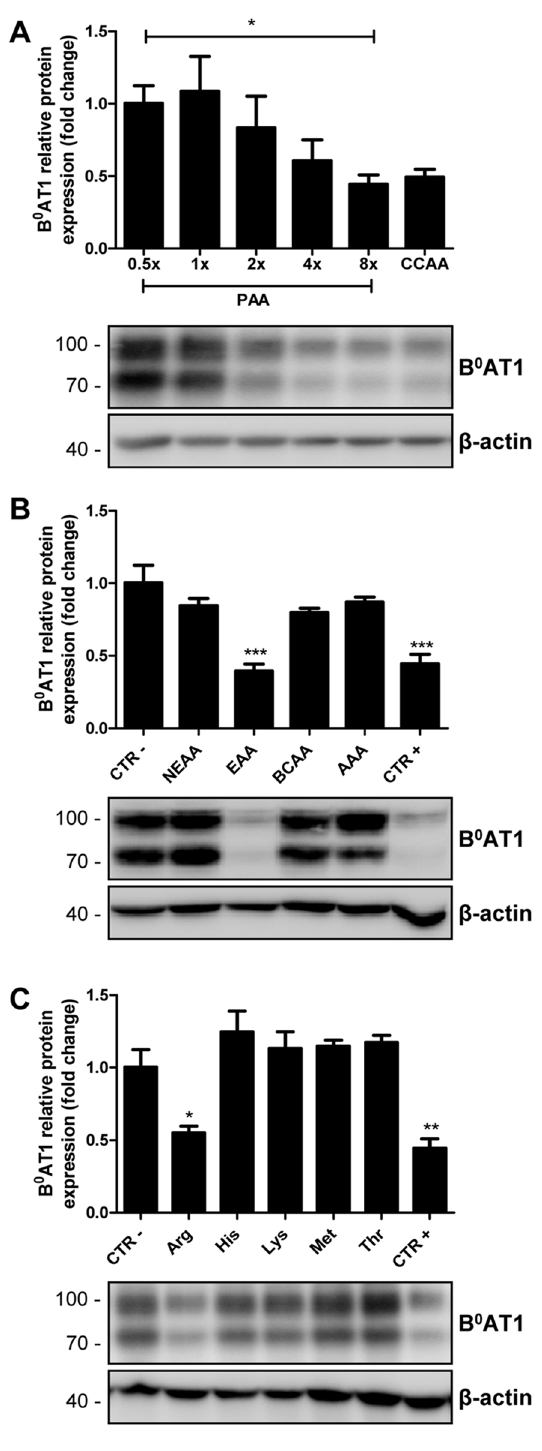
Figure 3. Transgene regulation by amino acids. A: Mycoplasma- infected B 0 AT1-TMEM27 overexpressing MDCK cells were incubated in standard cell culture medium (CCAA) or in amino acid-free medium complemented with different amounts (0.5 6 to 8 6 ) of an amino acid mixture corresponding to the concentrations found in post-absorptive mouse plasma (PAA doses). B 0 AT1 expression was analyzed by Western blotting and the intensity of the immunoreactive bands was quantified, standardized to b -actin and normalized to the level measured in 0.5 fold complemented medium. B-C: Mycoplasma-infected B 0 AT1-TMEM27 overexpressing MDCK cells were incubated in a modified